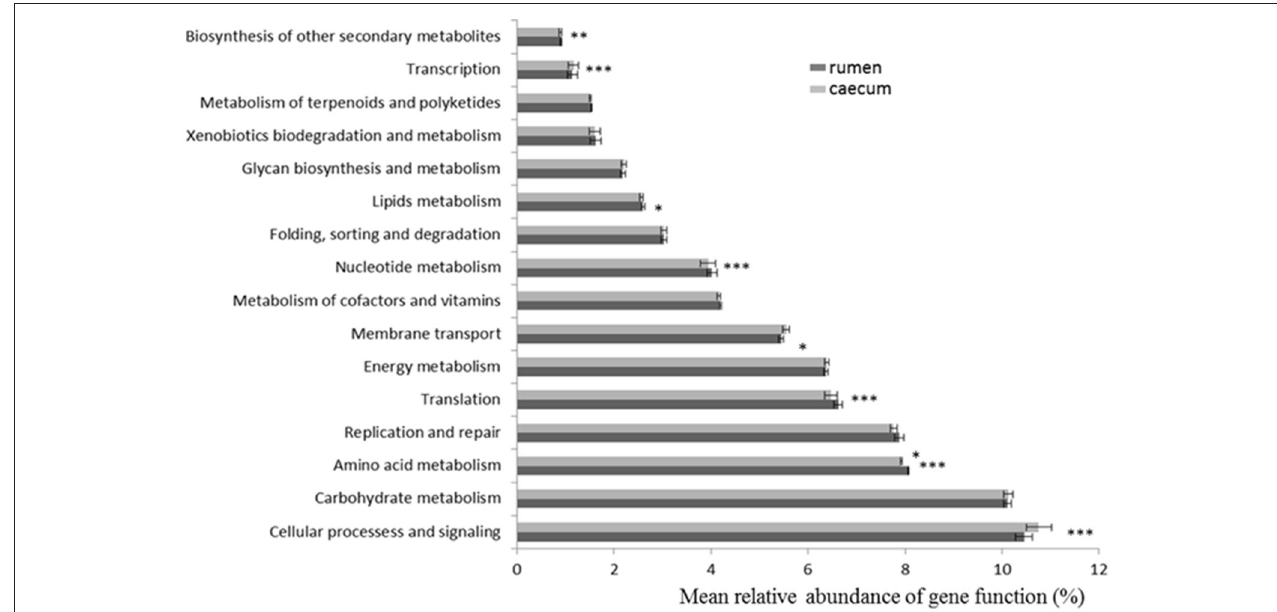
FIGURE 2 | Comparisons of the predominant gene pathways of the bacterial microbiota in rumen and cecum digesta samples predicted by PICRUSt (*** < 0.001, ** < 0.01, * < 0.05).